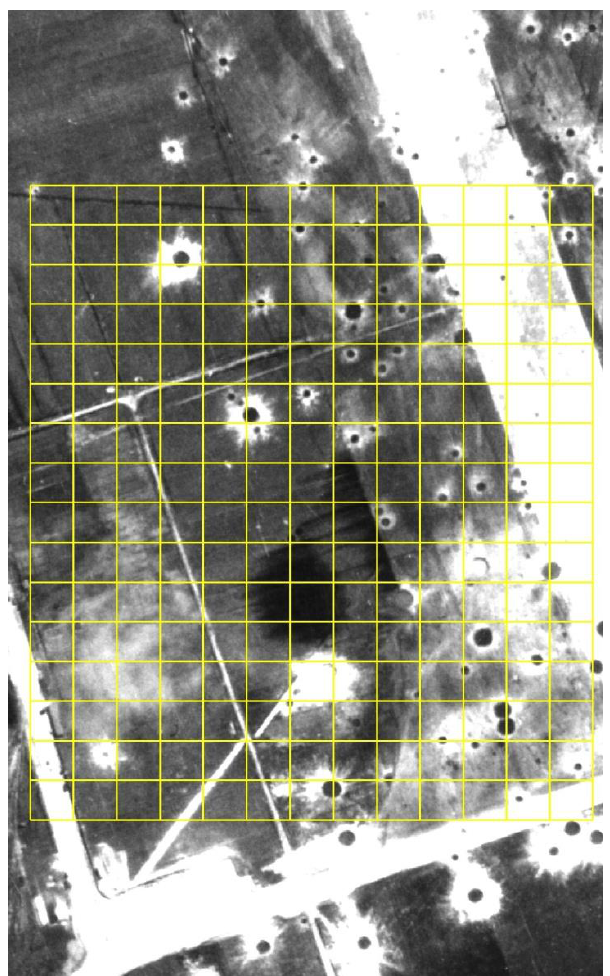
Figure 3. A bombarded area overlaid by a 30 meter